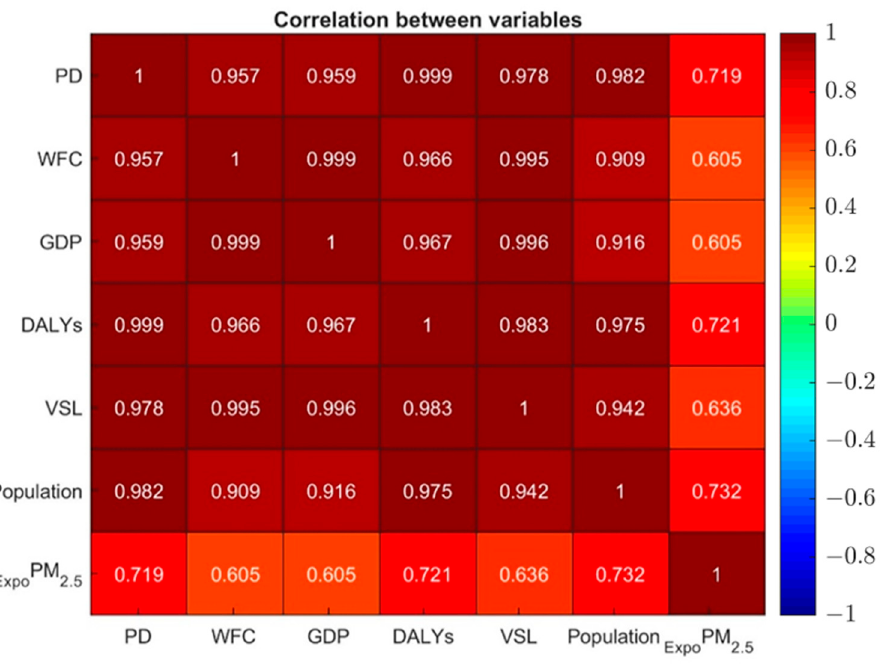
Figure 14. A heat map of values of the Pearson correlation coefficient (r) between seven variables. All r -values are significant at the 0.01 level ( p -value < 0.01, two-tailed).